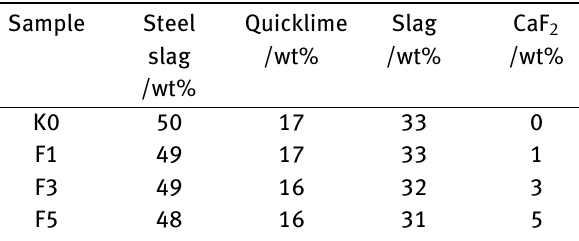
Table 2: Experimental proportions of the reconstructed steel slag with CaF 2 samples